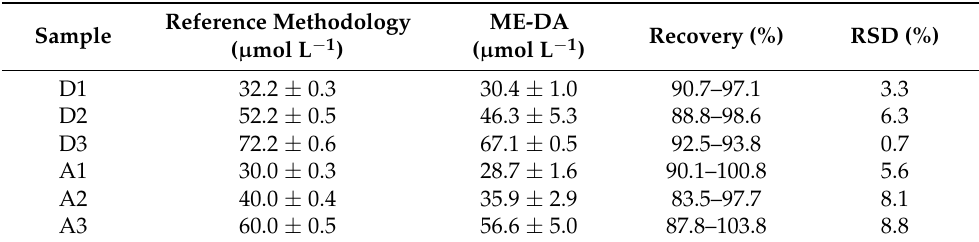
Table 3. Nitrite concentration values found in water samples using the reference and the proposed methodologies ( n =